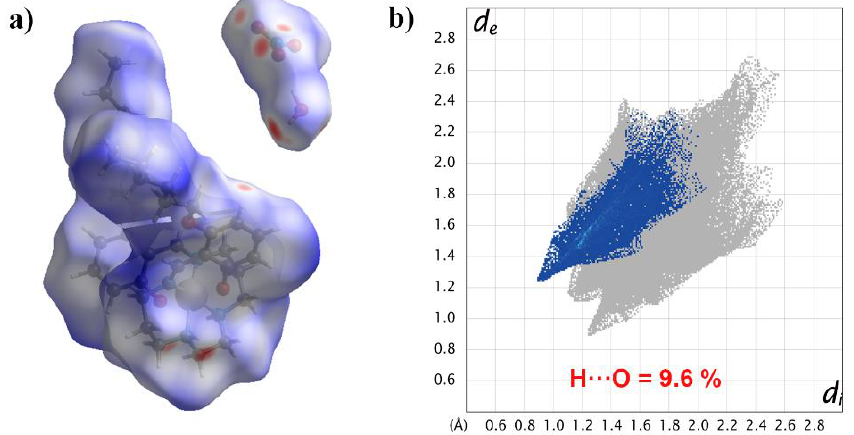
Figure 7. Hirshfeld surface mapped with d norm ( a ); 2D fingerprint plots of H ··· O for [Mn(4-OC 6 H 13 - sal-N-1,5,8,12)]NO 3 · H 2 O ( b ).